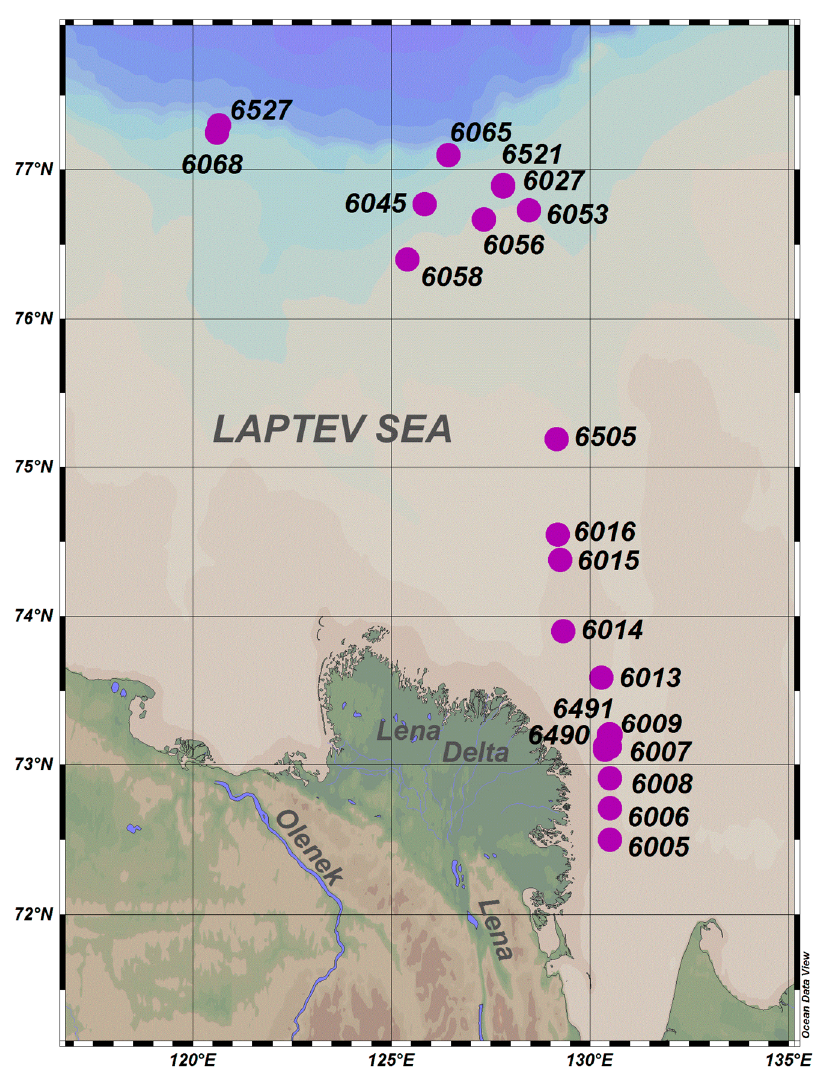
Figure 1. Study area in the Laptev Sea. Pink filled circles mark the sediment sampling sites.